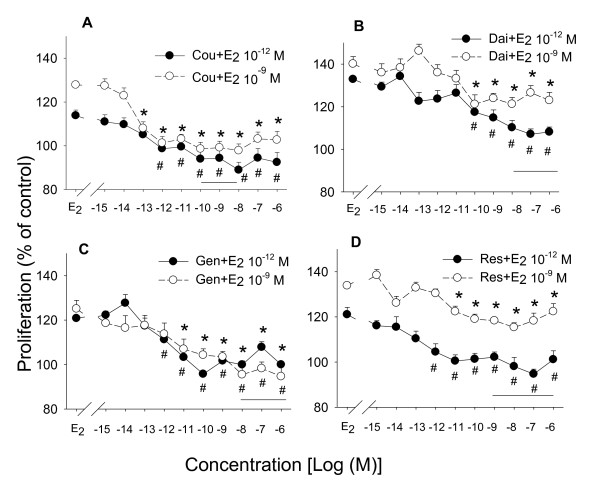
Proliferative effects of E2 in combination with different concentrations of phytoestrogens. GH3/B6/F10 cells were treated with different concentrations of phytoestrogens in the presence of either 10-9 M or 10-12 M E2. The cell numbers were measured after 3 days of treatment. (A) coumesterol (B) daidzein (C) genistein (D) trans-resveratrol. The solid horizontal line spans the reported concentrations of each estrogen in human serum or urine. * = p < 0.05 compared to 10-9 M E2. # = p < 0.05 compared to 10-12 M E2.